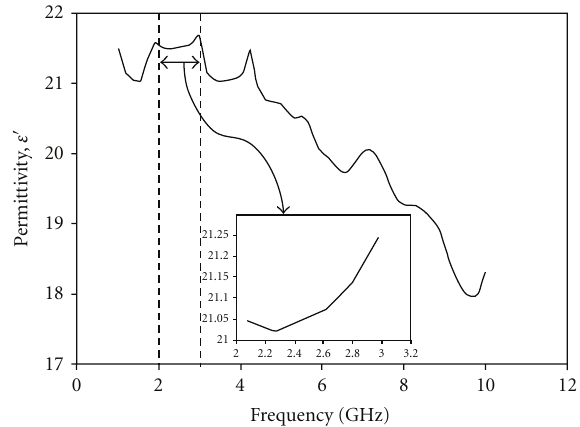
Figure 3: Permittivity of BiT ceramic at 1 to 10 GHz.